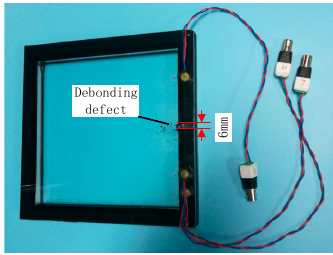
Figure 7. Artificial defect with 6 mm debonding.